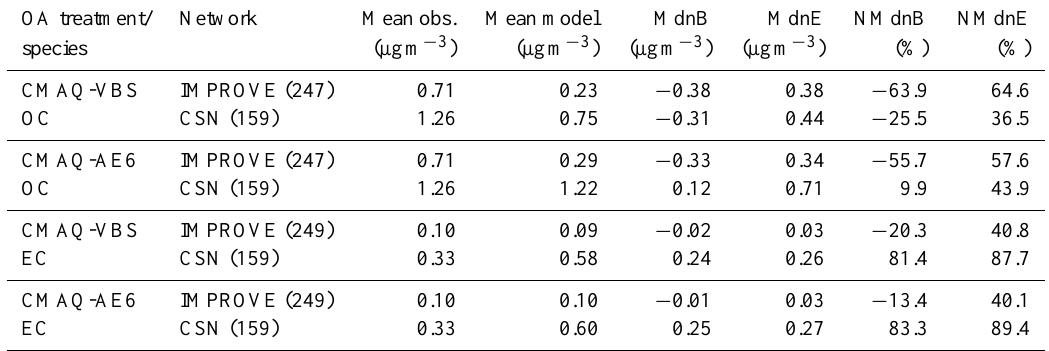
Table 3. CMAQ-VBS and CMAQ-AE6 organic carbon (OC) and elemental carbon (EC) model predictions evaluated against routine model- ing network sites in the modeling domain (IMPROVE and CSN). Evaluation metrics include median bias (MdnB a ), median error (MdnE b ), normalized median bias (NMdnB c ), and normalized median error (NMdnE d